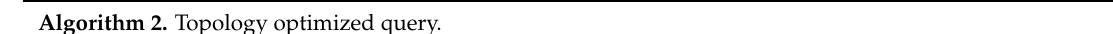
Algorithm 2. Topology optimized query.